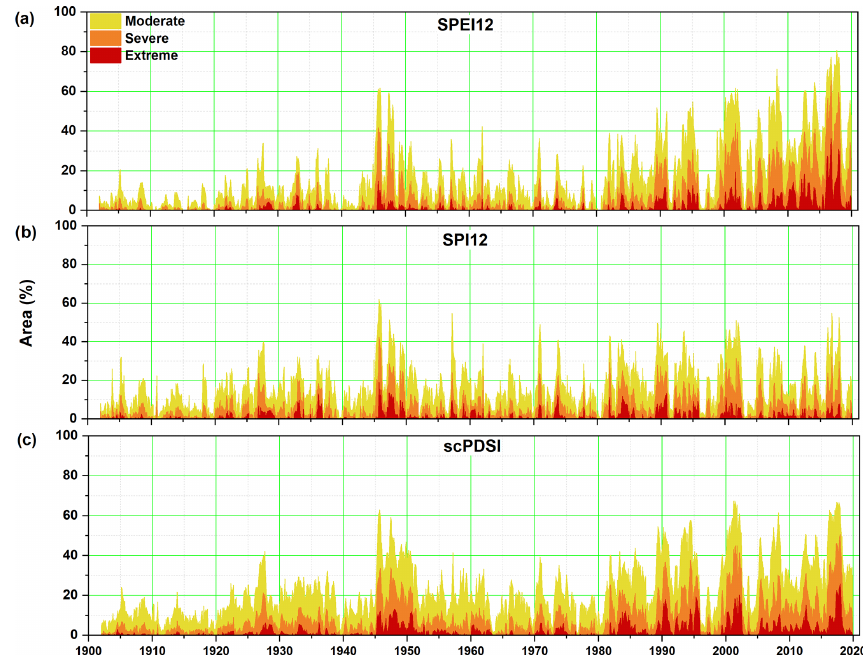
Figure 2. Temporal evolution of the percentage area affected by droughts over MED for the (a) SPEI12, (b) SPI12, and (c) scPDSI for three drought severity categories: moderate (yellow), severe (orange), and extreme (dark red). See text for the definition of the drought